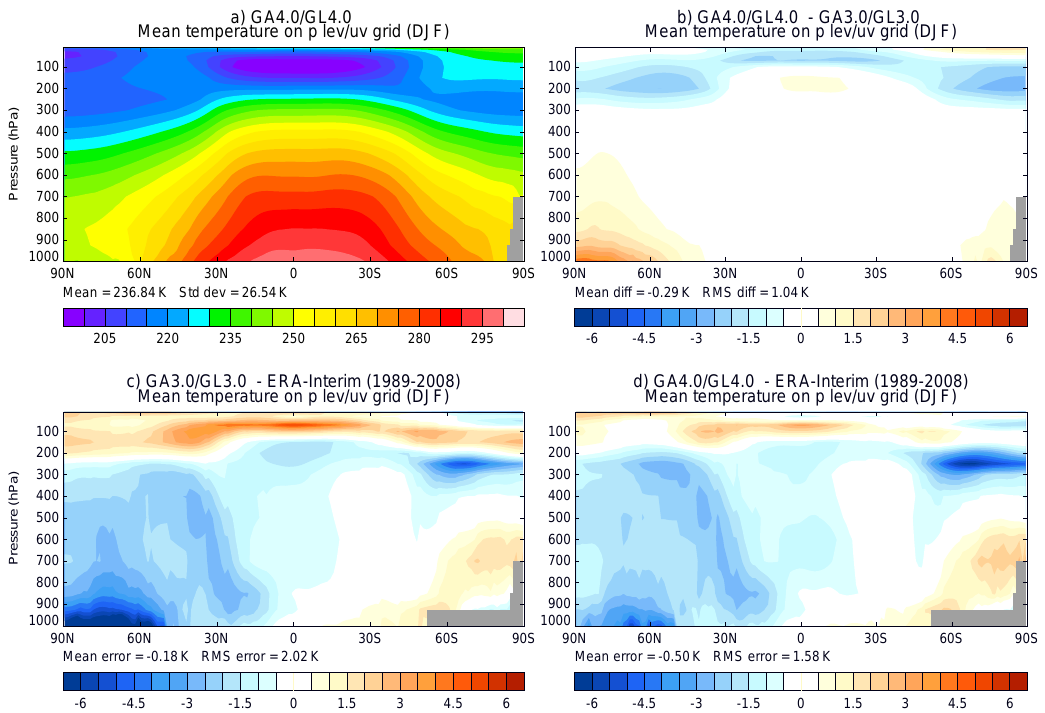
Fig. 7. Climatological zonal mean temperature field during DJF from years 11–60 of N96-AOIL_clim. (a) Full field from GA4.0/GL4.0, (b) model difference (GA4.0/GL4.0 minus GA3.0/GL3.0), (c) GA3.0/GL3.0 bias (GA3.0/GL3.0 minus verifying data set) and (d) GA4.0/GL4.0 bias (GA4.0/GL4.0 minus verifying data set). The verifying data set is the ERA-Interim reanalysis (Berrisford et al., 2009). Sea-surface Temperature and sea Ice Analysis; Don- lon et al., 2012). The trial periods used are 4 June– 14 July 2011 and 18 January 2012–18 February 2012, with two main forecasts per day initialised at 00:00 and 12:00 UTC.